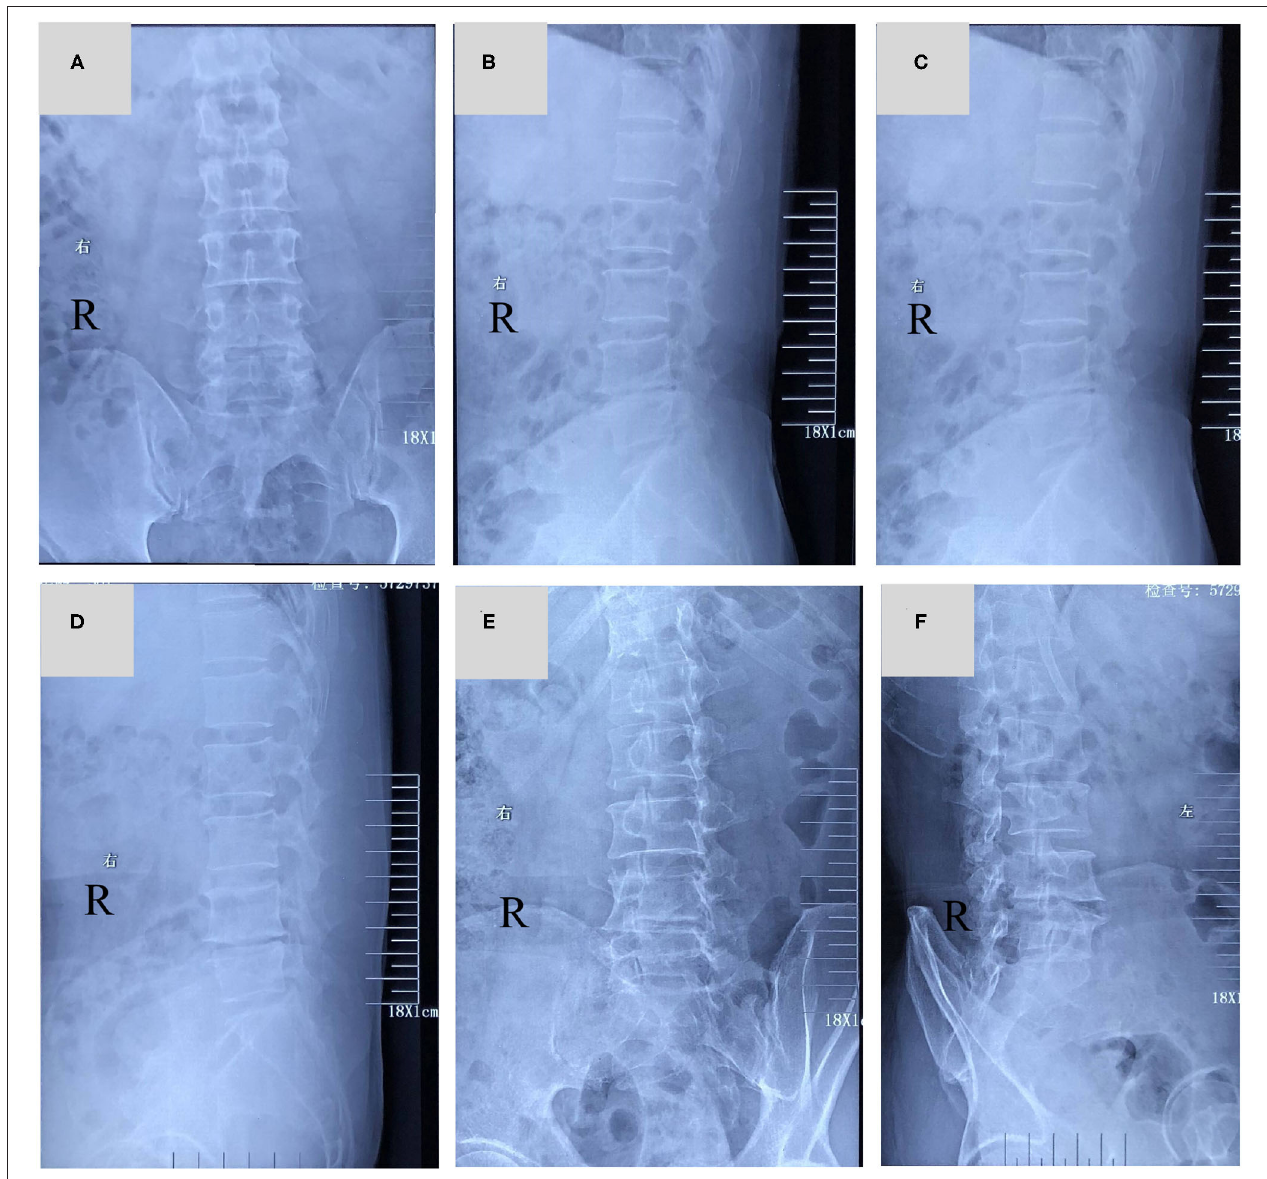
FIGURE 1 | (A–F) lumbar vertebrae X-ray in 6 position: X-ray films showed that the L4/5 intervertebral height was obviously